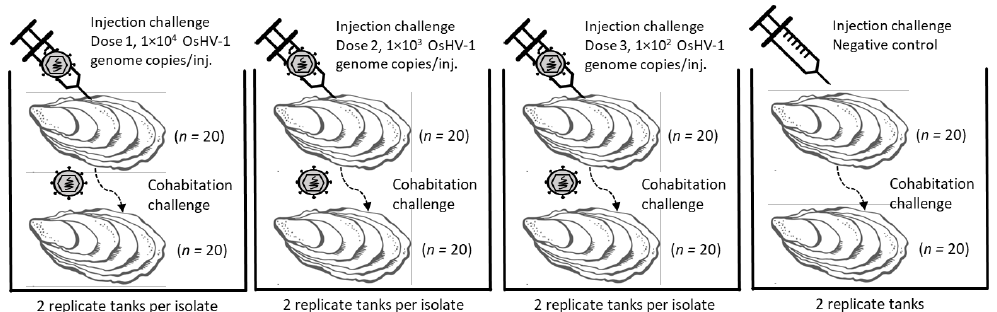
Figure 1. Experiment design to compare isolates of microvariant OsHV-1. Primary inoculae were prepared from oyster tissues collected during Pacific oyster mortality disease surveillance that were stored at − 80 ◦ C. Primary in vivo passage of each isolate by injection of Pacific oysters from the same hatchery and batch origin was used to reduce the impact of storage time, stage of infection, and status of primary host. The virulence and transmissibility of each OsHV-1 isolate was then compared using injection challenge with three doses of the secondary inoculae and by cohabitation with these injected oysters in replicate